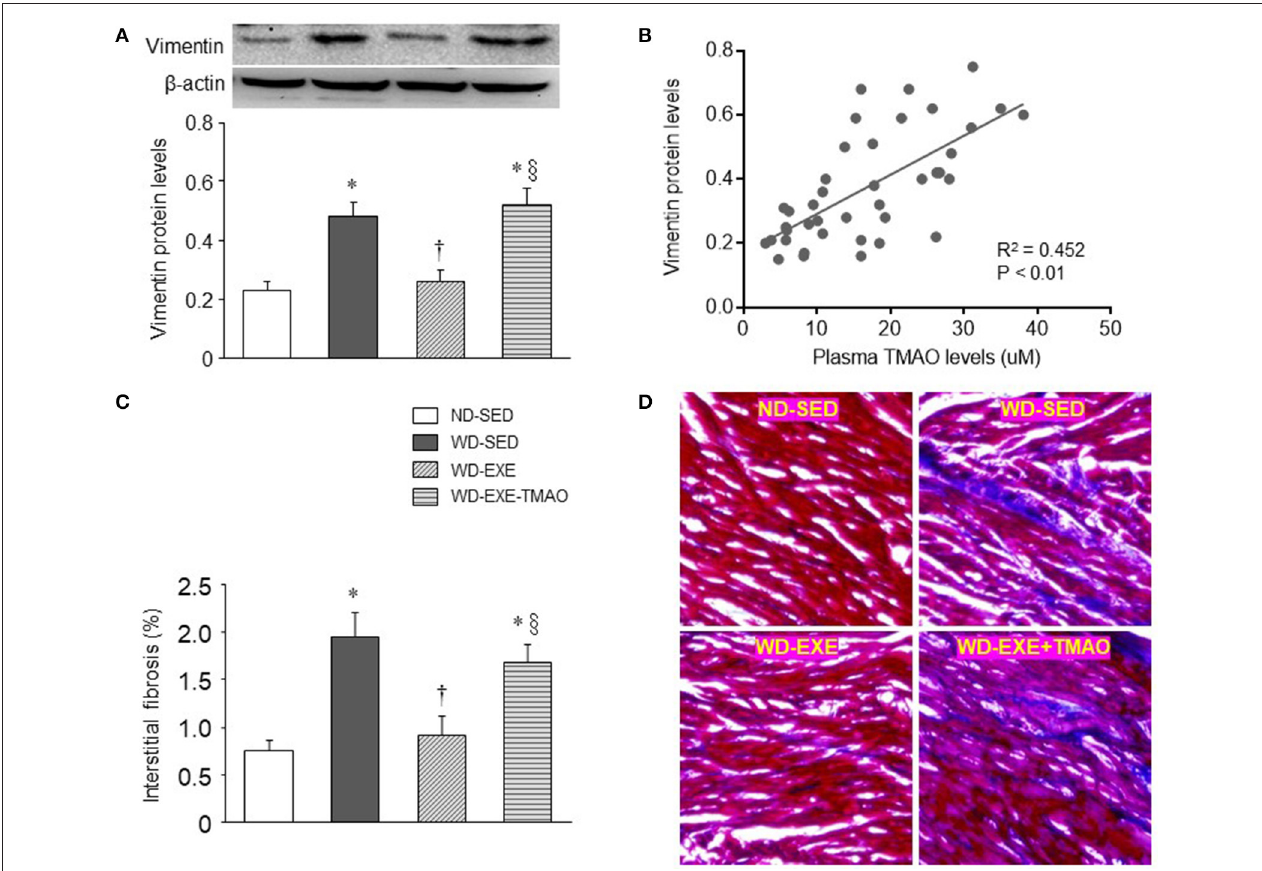
FIGURE 4 | Effects of voluntary exercise and TMAO supplementation on myocardial fibrosis in mice fed a western diet (WD). Compared with normal diet (ND)-sedentary mice, WD-sedentary mice had increased protein levels of vimentin (a marker of fibroblasts, A) and interstitial fibrosis (C) in the heart, which were prevented by voluntary exercise. Concomitant administration of TMAO abrogated the beneficial effects of voluntary exercise on protein levels of vimentin and interstitial fibrosis. Notably, plasma TMAO levels were significantly correlated with protein levels of vimentin in the heart (B) . Representative images of Masson Trichrome staining in heart sections are shown in (D) . Sedentary: SED; voluntary exercise: EXE. Data are presented as mean ± SE ( n = 10 for each group). * P < 0.05 vs. ND-SED; † P < 0.05, WD-EXE vs. WD-SED; § P < 0.05, WD-EXE-TMAO vs.